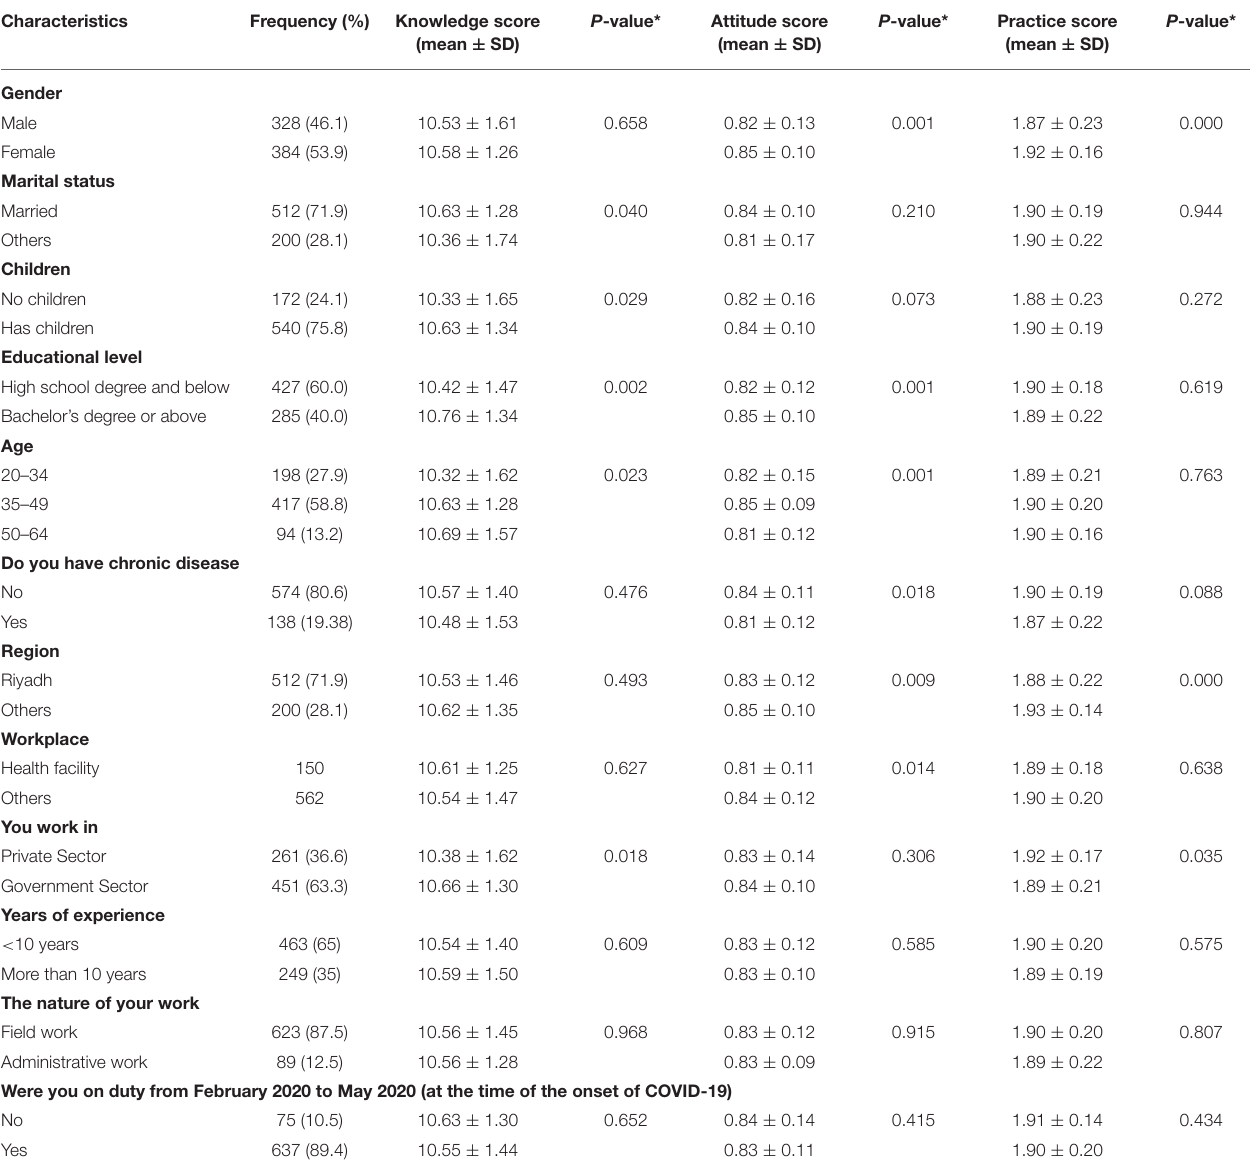
Table 7 | Influence of respondent characteristics on their level of knowledge, attitude, and practice toward COVID-19 ( n = 712).